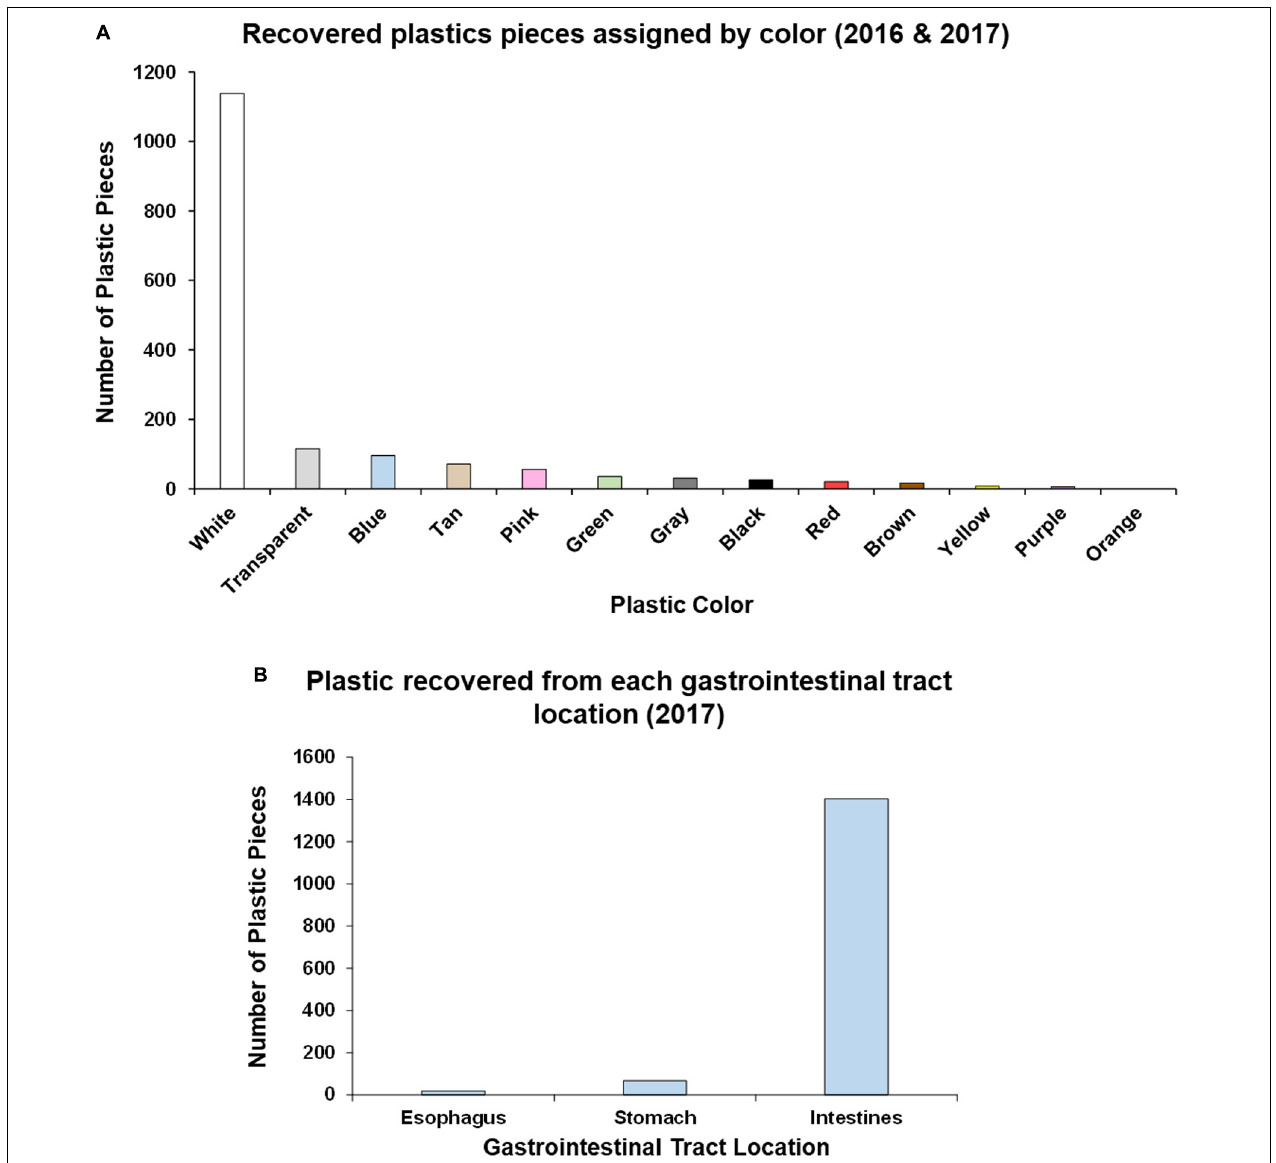
FIGURE 3 | Analysis of plastic ingestion recovery location and color in post-hatchling washbacks. (A) Quantity of plastic pieces of each color recovered from washback necropsies (2016 and 2017). (B) Quantity of plastic pieces recovered from each gastrointestinal tract location